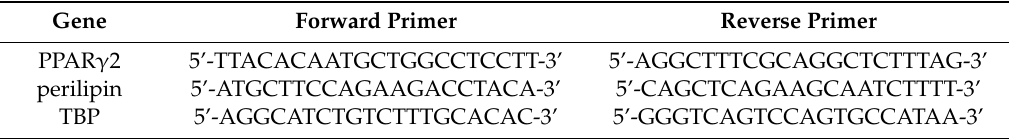
Table 2. The Specific Primer Sequences used for Gene Expression